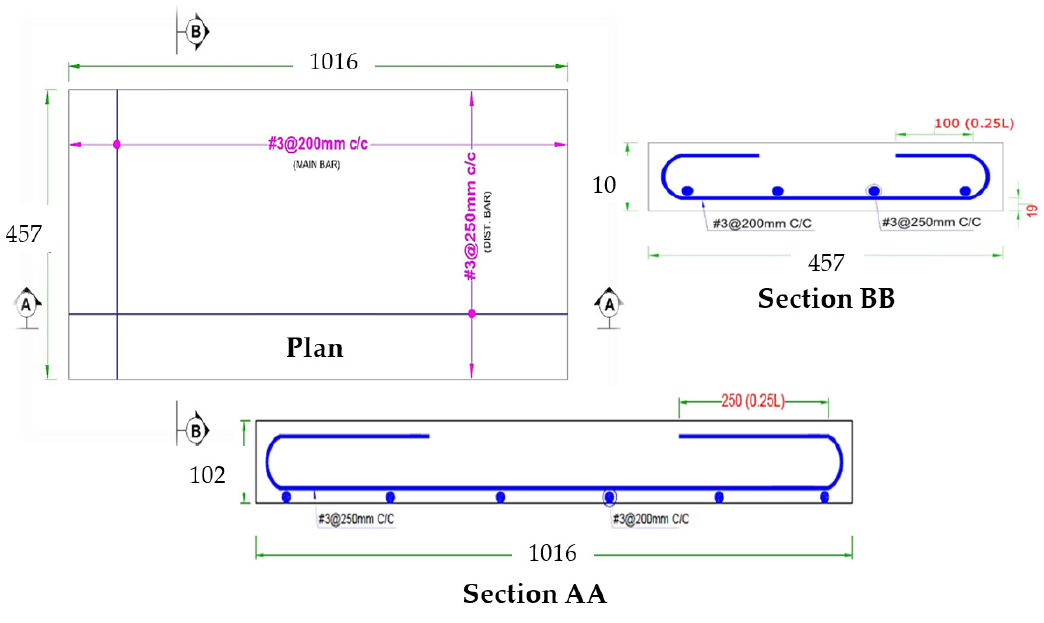
Figure 4. Reinforcement detail of control slab (All dimensions are in mm).